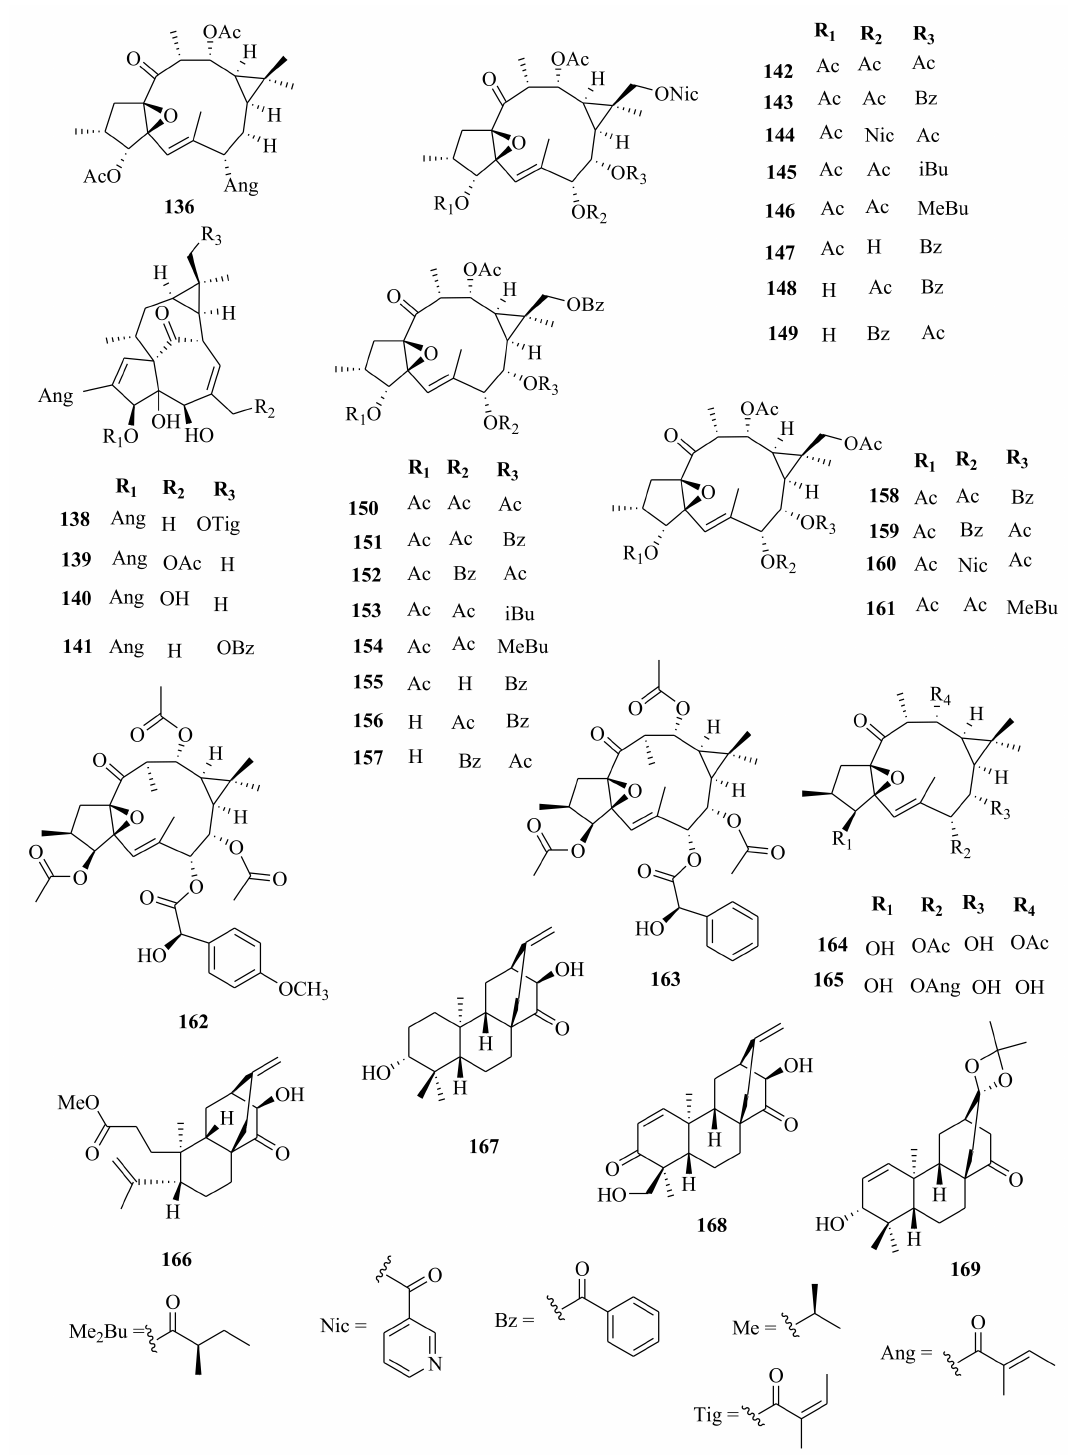
Figure 7. Continued: Chemical structures of ingol and ingenol